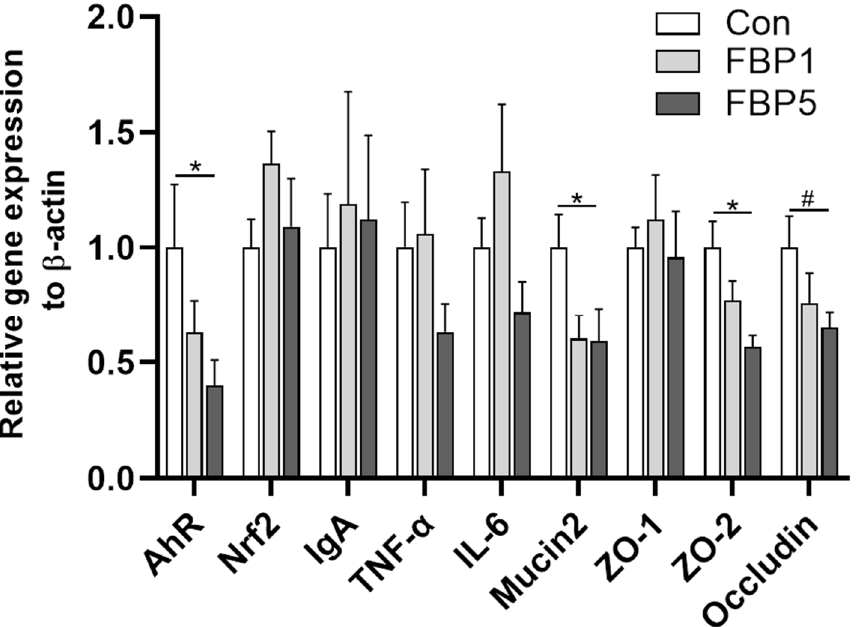
Figure 8. Dietary effects of the Lp ‐ fermented B. papyrifera product (FBP) under practical condition on the antioxidant, barrier function, and immune related gene expression in ileum of laying hens. Con: the hens fed with basal diet; FBP1, the hens fed with 1% (wt/wt) FBP product in basal diet; FBP5, the hens fed with 5% (wt/wt) FBP product in basal diet. * indicates significant difference among the treatments at p < 0.05 level; # indicates significant difference among the treatments at 0.05 < p < 0.10 level.